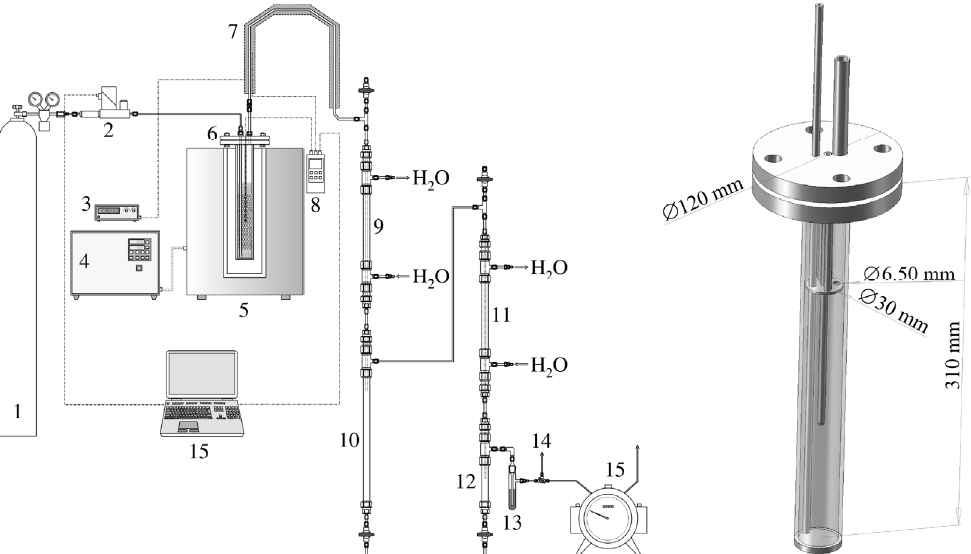
Figure A1. The pyrolysis apparatus and a removed pyrolysis/activation retort (1—pressure cylinder with N 2 , 2—gas flow meter/controller, 3—heating controller of the retort output, 4—furnace heating controller, 5—cylindrical furnace, 6—retort with a sample, 7—heated pipe of the primary pyrolysis gas, 8—thermometer, 9—primary cooler, 10—primary condensate collector, 11—secondary cooler, 12—secondary condensate collector, 13—aerosol filter, 14—three-way valve for gas sampling, and 15—drum gas meter).